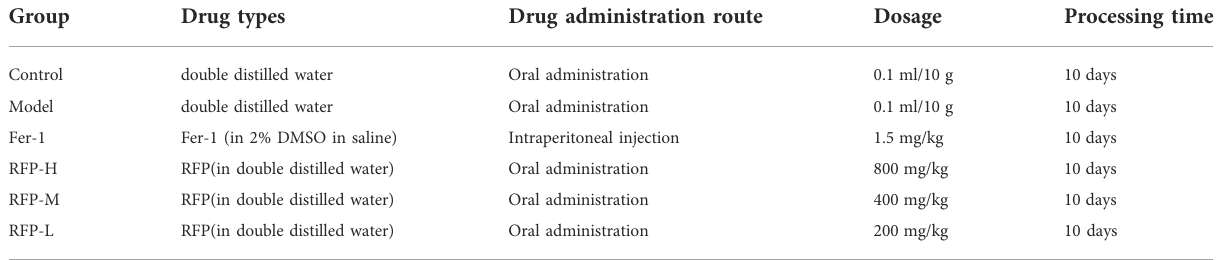
TABLE 1 Types and doses of drugs administered to different groups of mice.